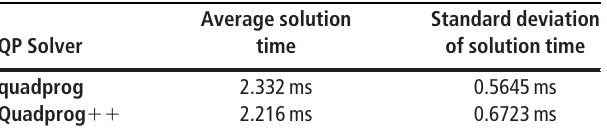
Table 7 Solution time information of hardware